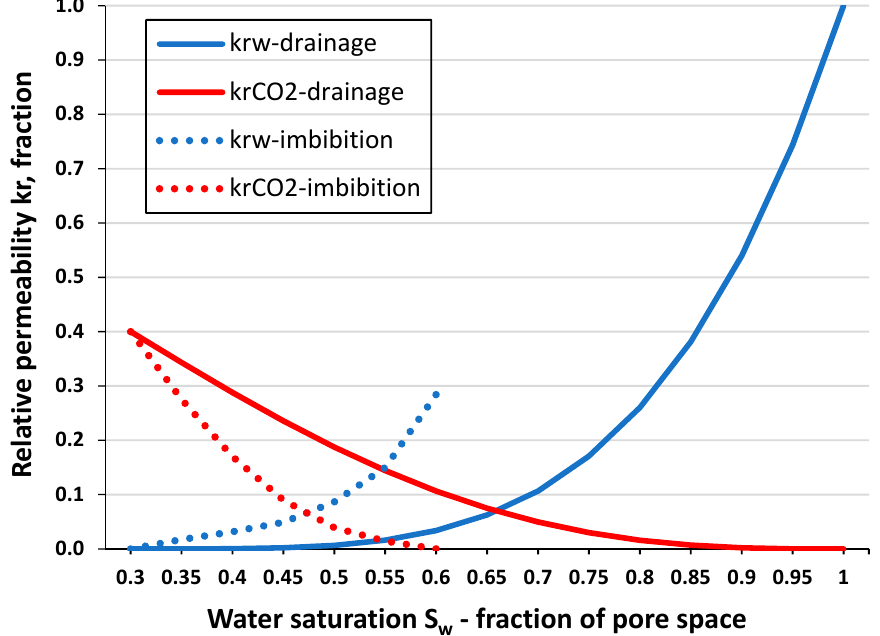
Figure 6. Relative permeability curves with the hysteresis effect used in numerical modelling.